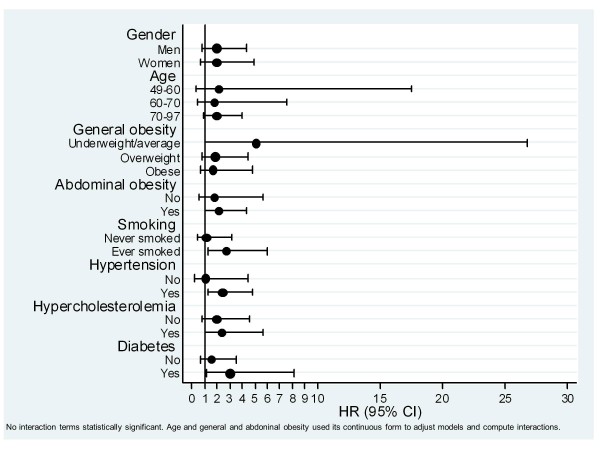
Effect of arterial calcification for cerebrovascular disease, measured by hazard ratio (HR), among different potential cardiovascular risk factors.